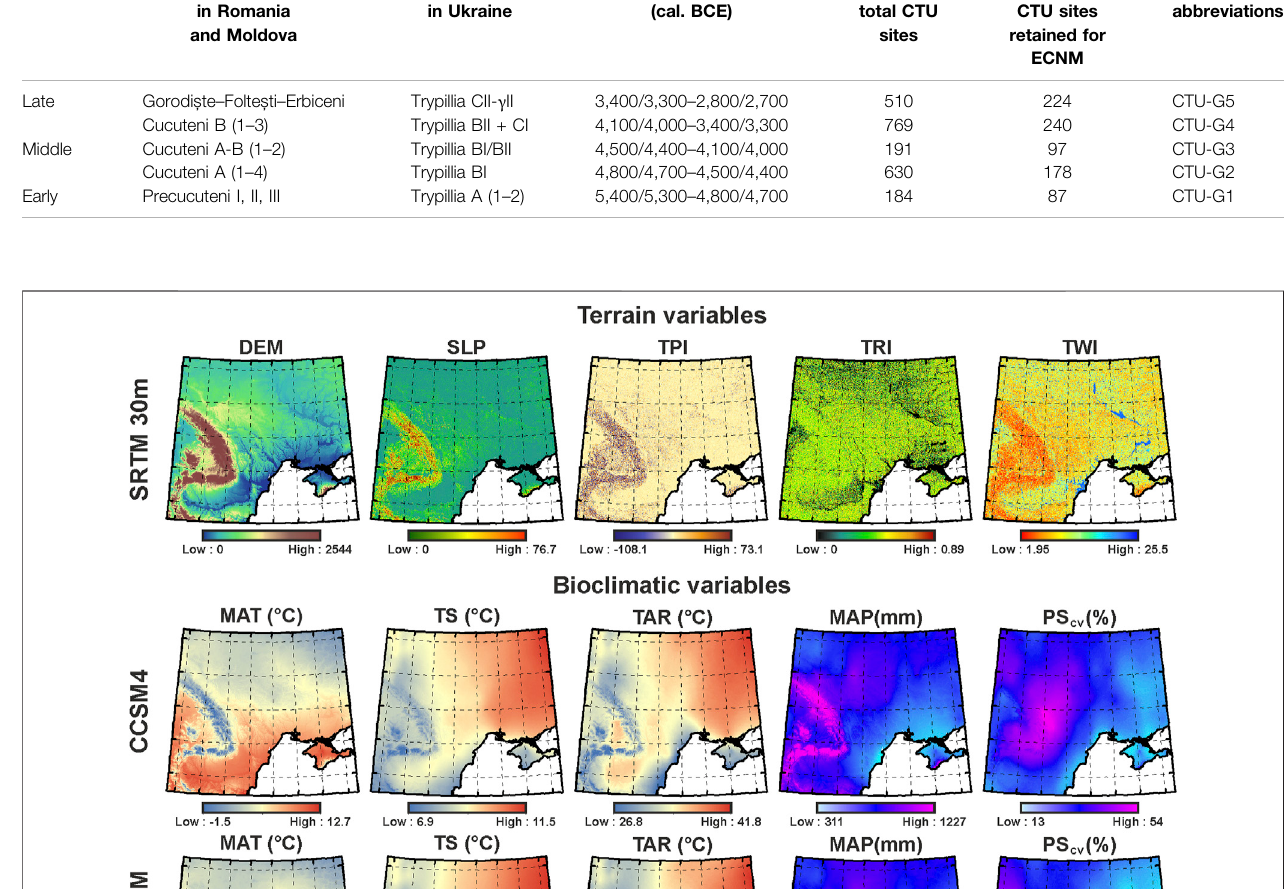
Frontiers in Earth Science |